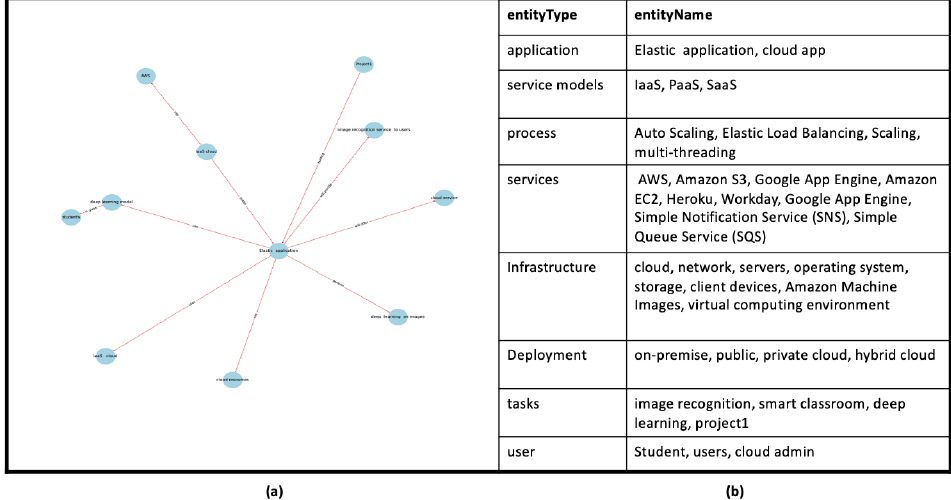
Figure 9. Cloud computing entity extraction ( a ) The first figure represents the preliminary graph generated by extracting raw entities and relations from unstructured text ( b ) The second figure shows the key entities identified by the domain expert using the raw entities and visual